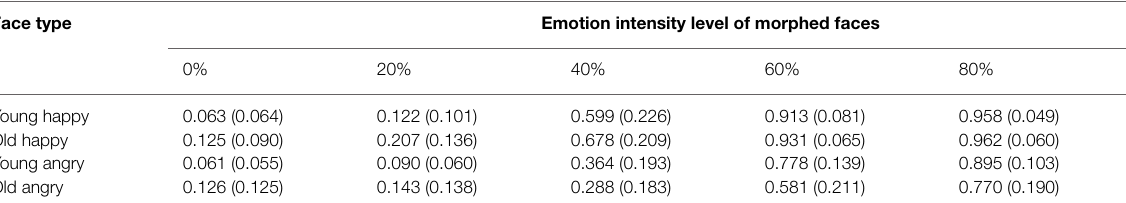
TABLE 1 | Means and standard deviations of the proportion of happy and angry decisions.